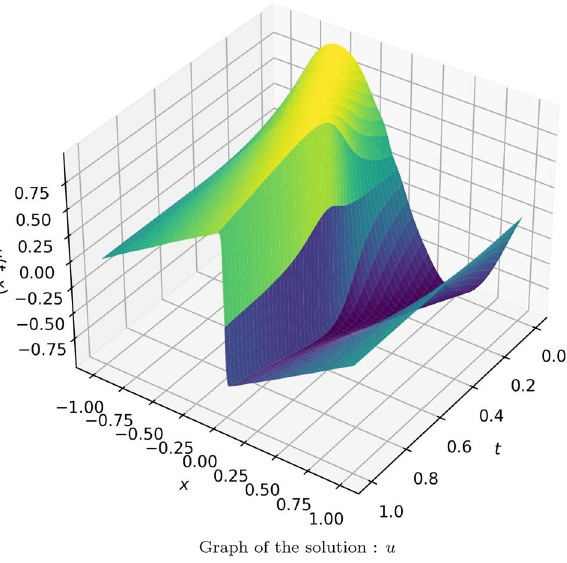
Figure 15. Solution obtained for the Burger’s equation (case 2) using the proposed method with Gaussian wavelet.